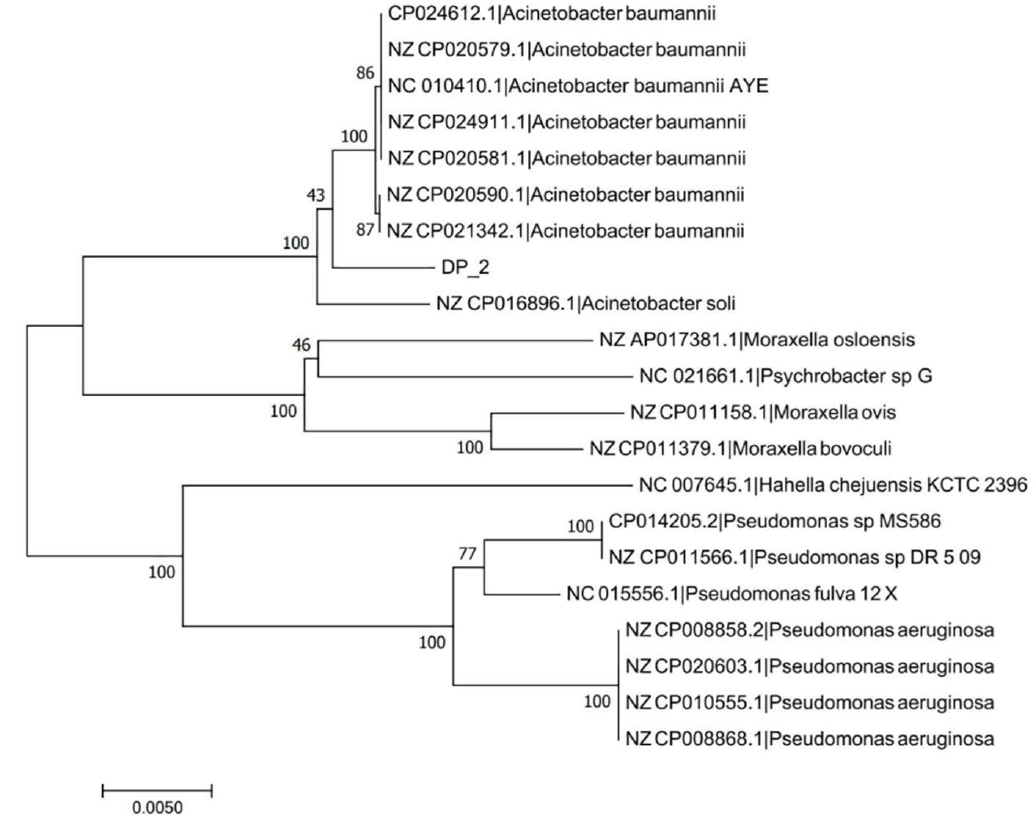
Figure 2. Phylogenetic tree of Acinetobacter baumannii DP-2 based on 16S rDNA sequences.